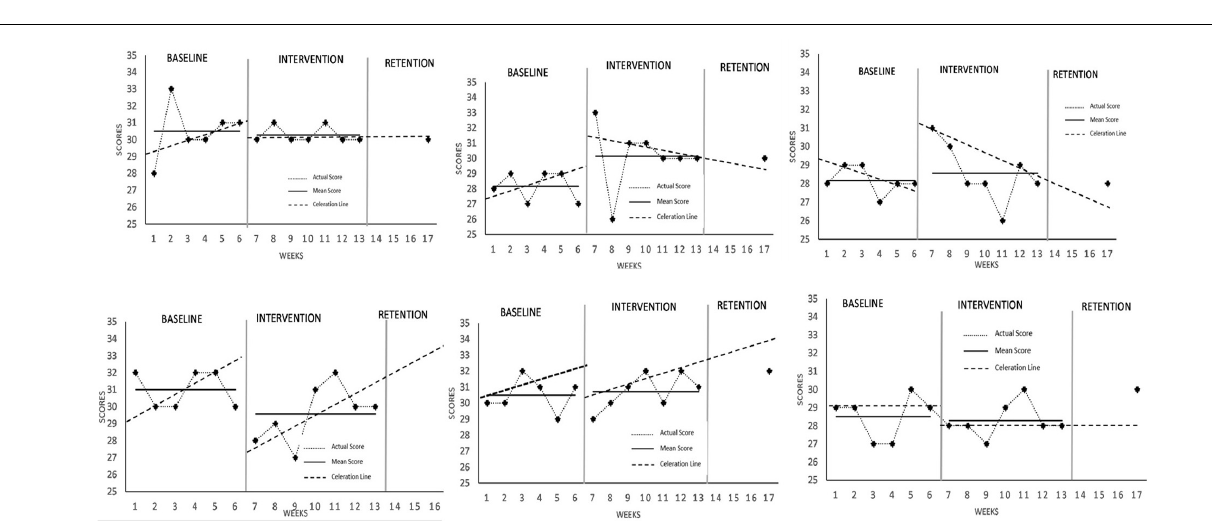
FIGURE 1 | Mindfulness attention awareness scale (MAAS) scores across all participants.